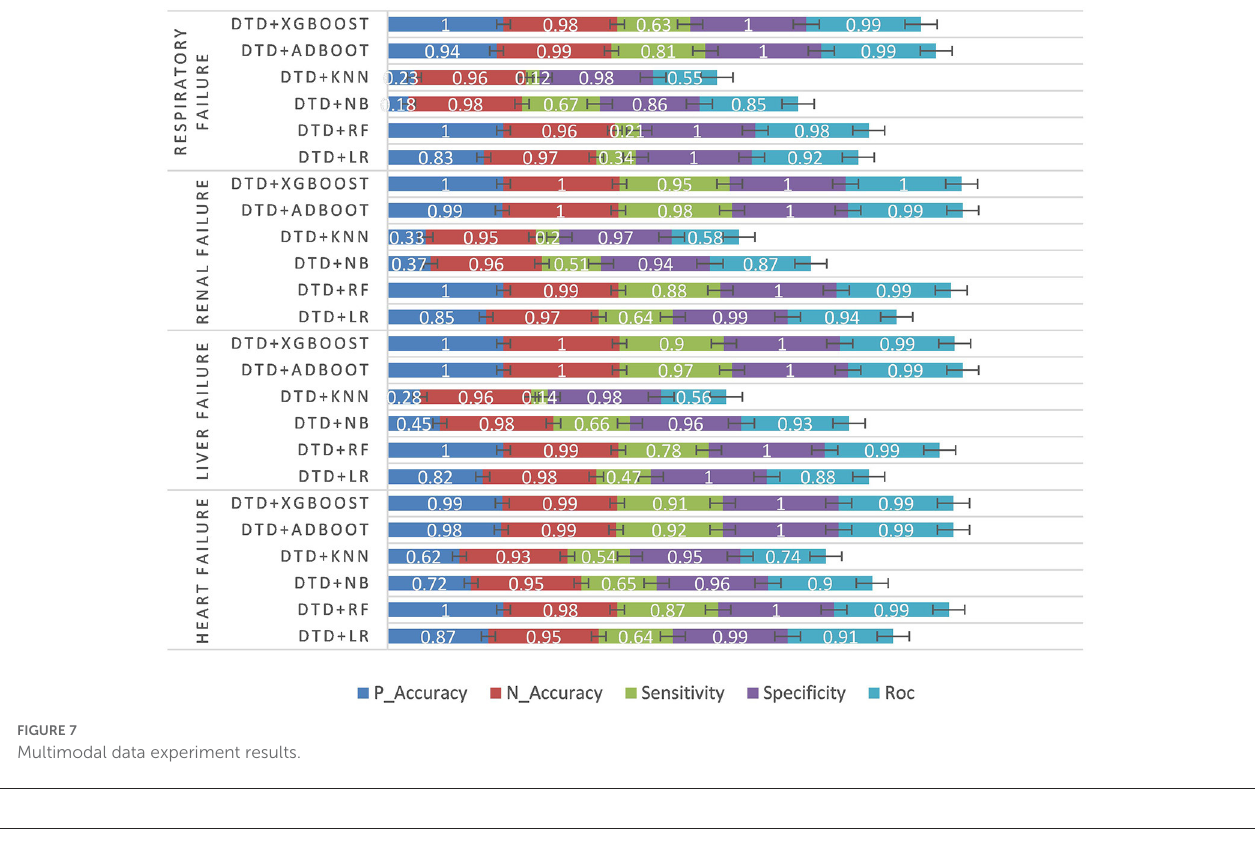
FIGURE7 Multimodal data experiment results.